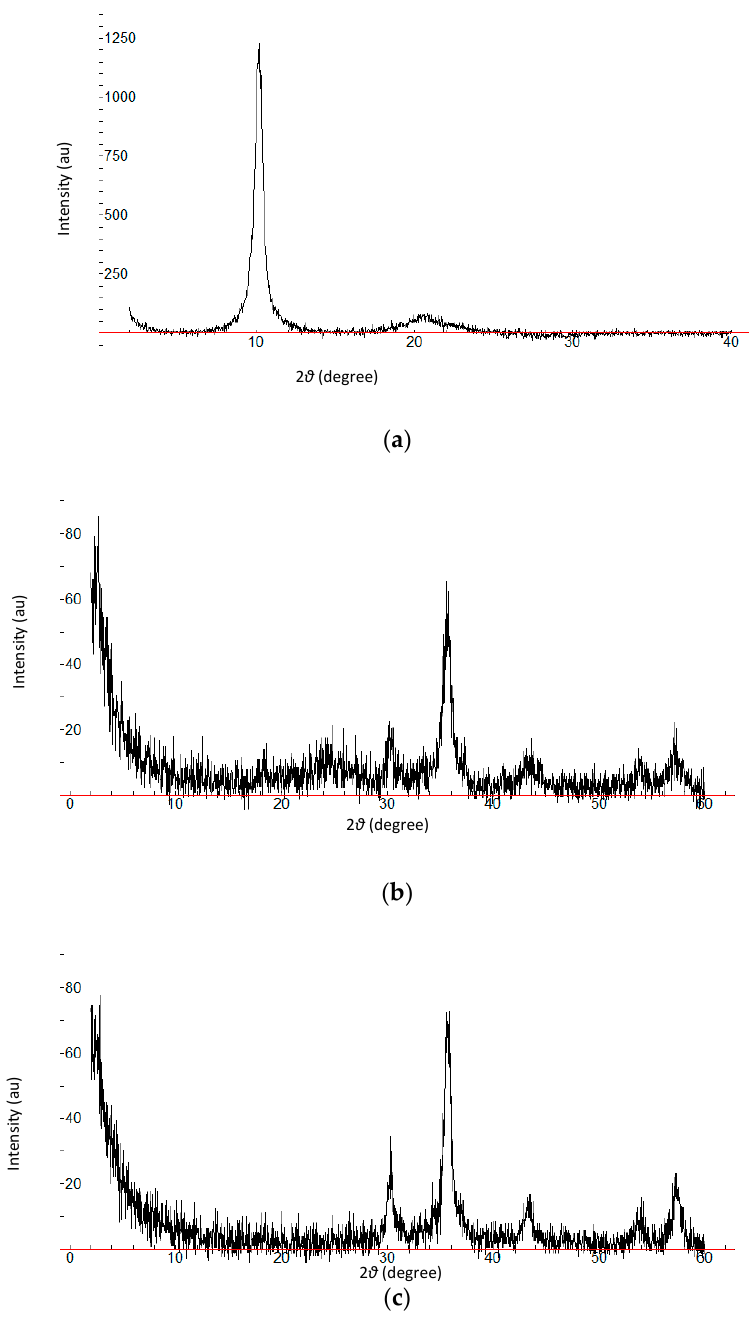
Figure 1. XRD patterns of ( a ) GO, ( b ) rGO, and ( c ) mrGO. X axis:2 θ (degree), Y axis: Intensity (au)